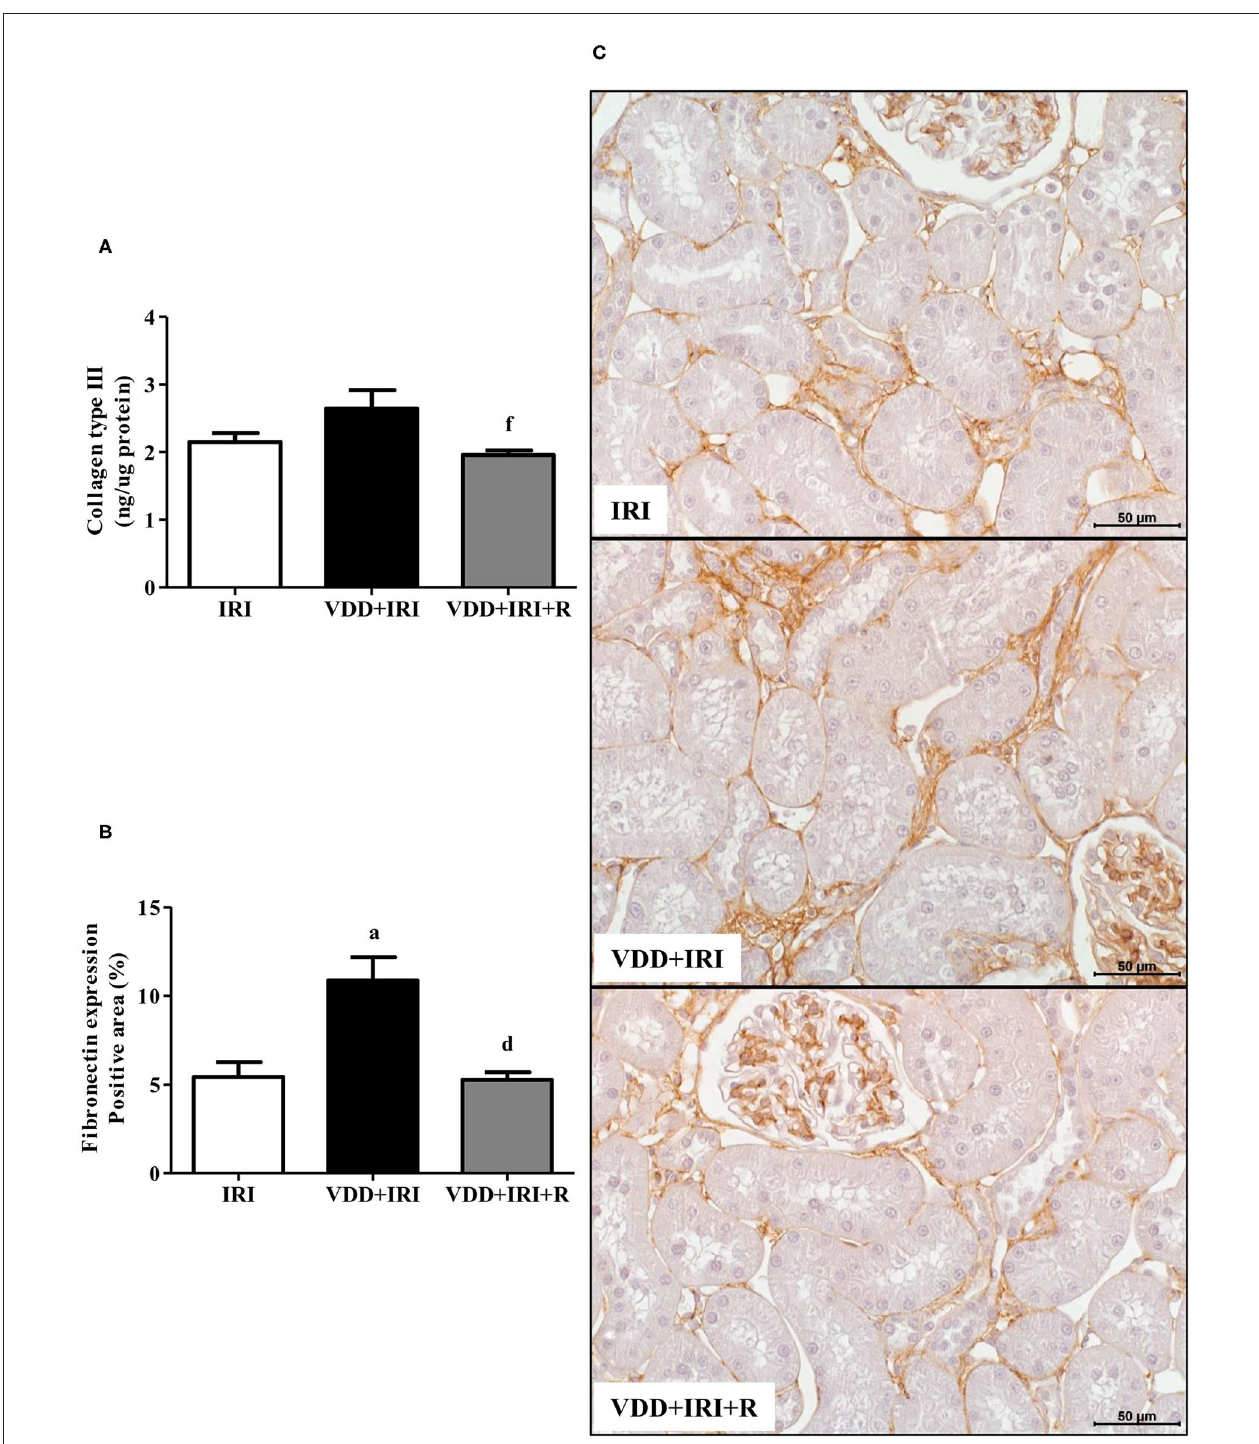
FIGURE 7 | Quantitative amount of collagen type III (COL3)—ELISA and immunohistochemical analysis for fibronectin expression in the kidney tissue evaluated 90 days after ischemia/reperfusion insult (IRI) on day 30. (A) Bar graphs of COL3 and (B) fibronectin expression values. (C) Representative photomicrographs of immunostaining for fibronectin in the renal cortex from an IRI, VDD + IRI and VDD + IRI + R rat ( × 400). Note that vitamin D replacement restored the expression of both COL3 and fibronectin in the VDD + IRI + R rats. Data are mean ± SEM. a p < 0.001 vs. IRI; d p < 0.001, f p < 0.05 vs. VDD + IRI. VDD, vitamin D deficiency; R, vitamin D replacement. Diet protocol: IRI, standard diet for 120 days; VDD + IRI, vitamin D-free diet for 120 days; and VDD + IRI + R, vitamin D-free diet in the first 30 days and standard diet in the last 90 days.